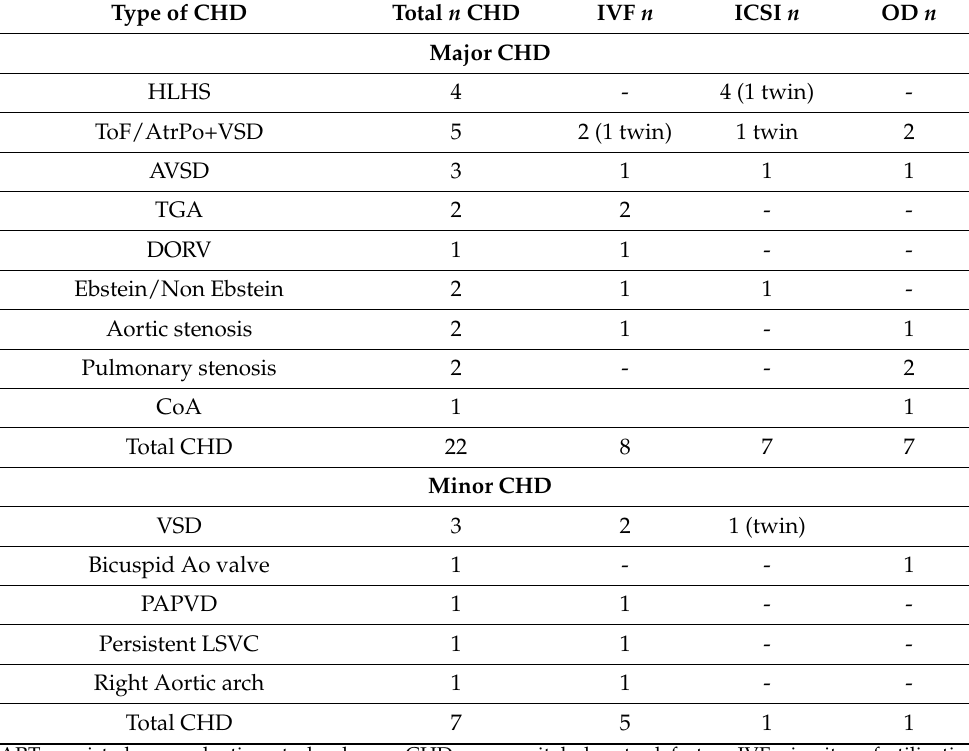
Table 3. Different types of congenital heart defects according to the type of